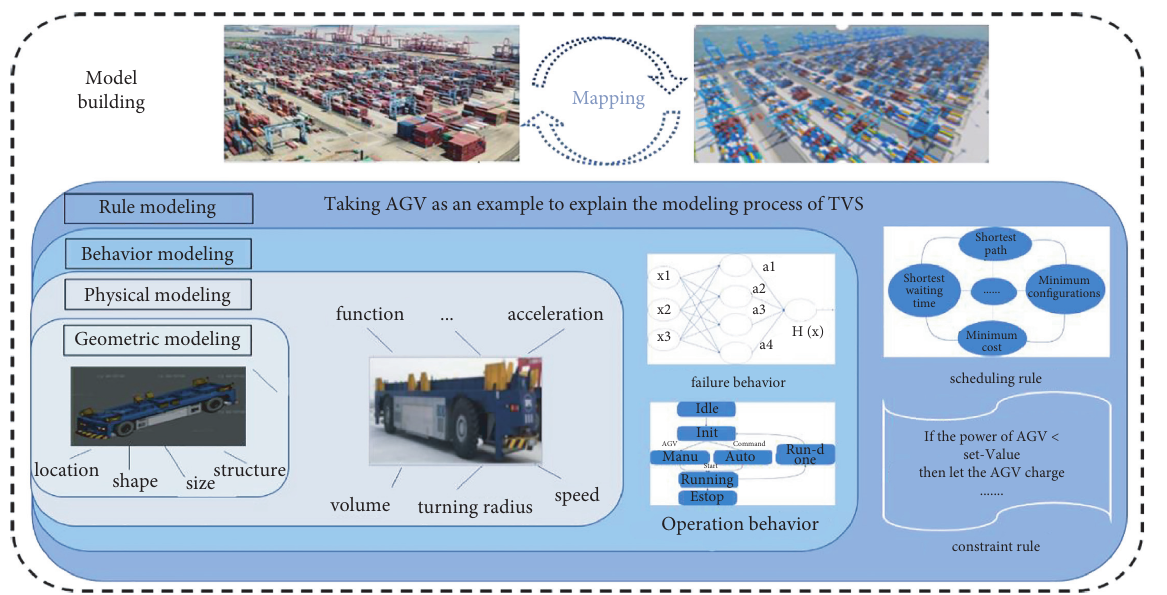
Figure 3: Modeling process of the AGV multidimensional twin